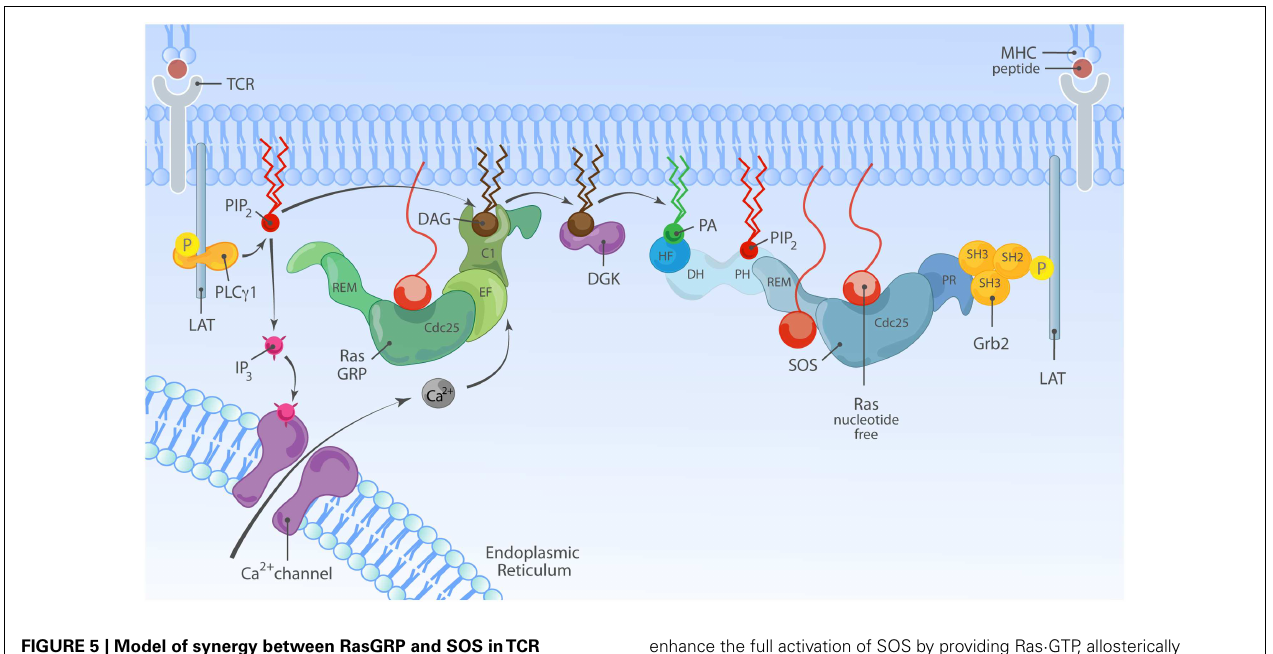
FIGURE 5 | Model of synergy between RasGRP and SOS inTCR signaling .TCR stimulation is connected to activation of RasGRP via tyrosine phosphorylation of the adapter molecule LAT and activation of PLC γ 1, that metabolizes PIP 2 into IP 3 and DAG to trigger two second messenger pathways; Ca 2 + and DAG. Activated RasGRP can